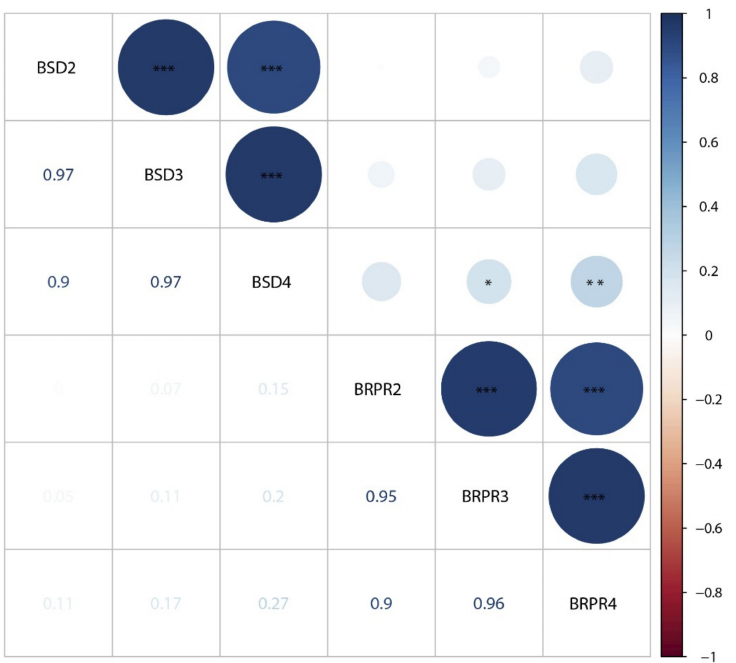
Figure 2. Correlation analysis between SD and RPR based on BLUP values across four environments. Size and color of dots in the upper triangle indicate the degree and direction of correlation, respec- tively; values in the lower triangle indicate Pearson’s correlation coefficients. BSD2, BSD3, and BSD4 represent BLUP values for SD2, SD3, and SD4, respectively. BRPR2, BRPR3, and BRPR4 represent BLUP values for RPR2, RPR3, and RPR4, respectively. *, **, ***: correlation significant at the 0.05, 0.01, and 0.001 level,